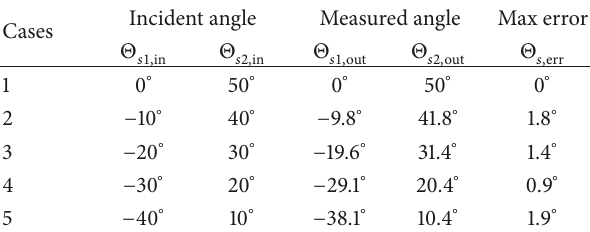
Table 1: Angle estimation.